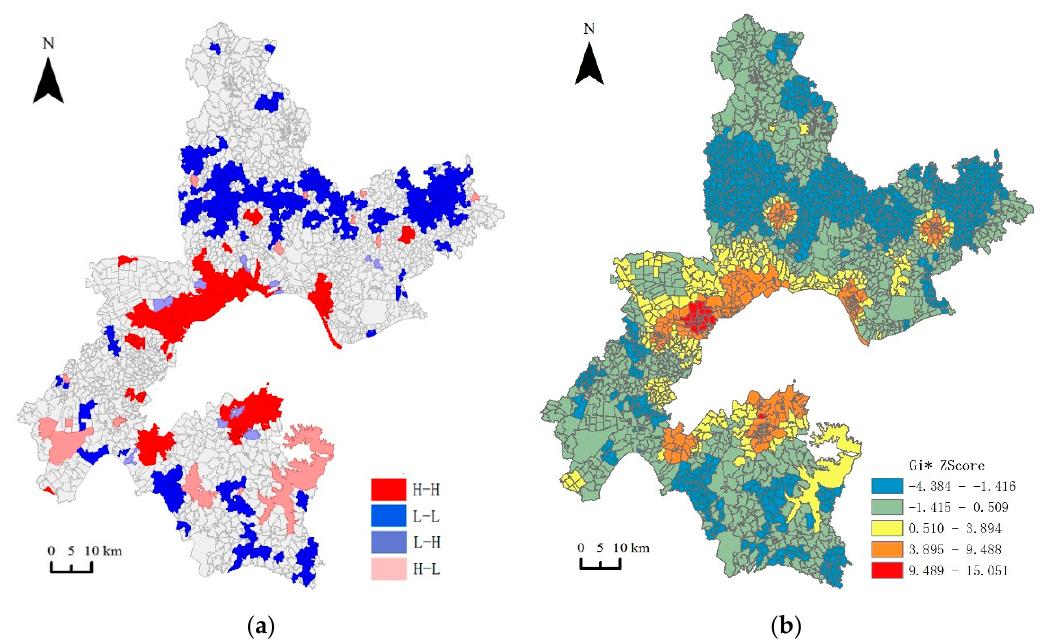
Figure 5. Local Indicators of Spatial Association (LISA) ( a ) and cold hot spots ( b ) of rural development level in administrative villages of Wuhan City’s new urban